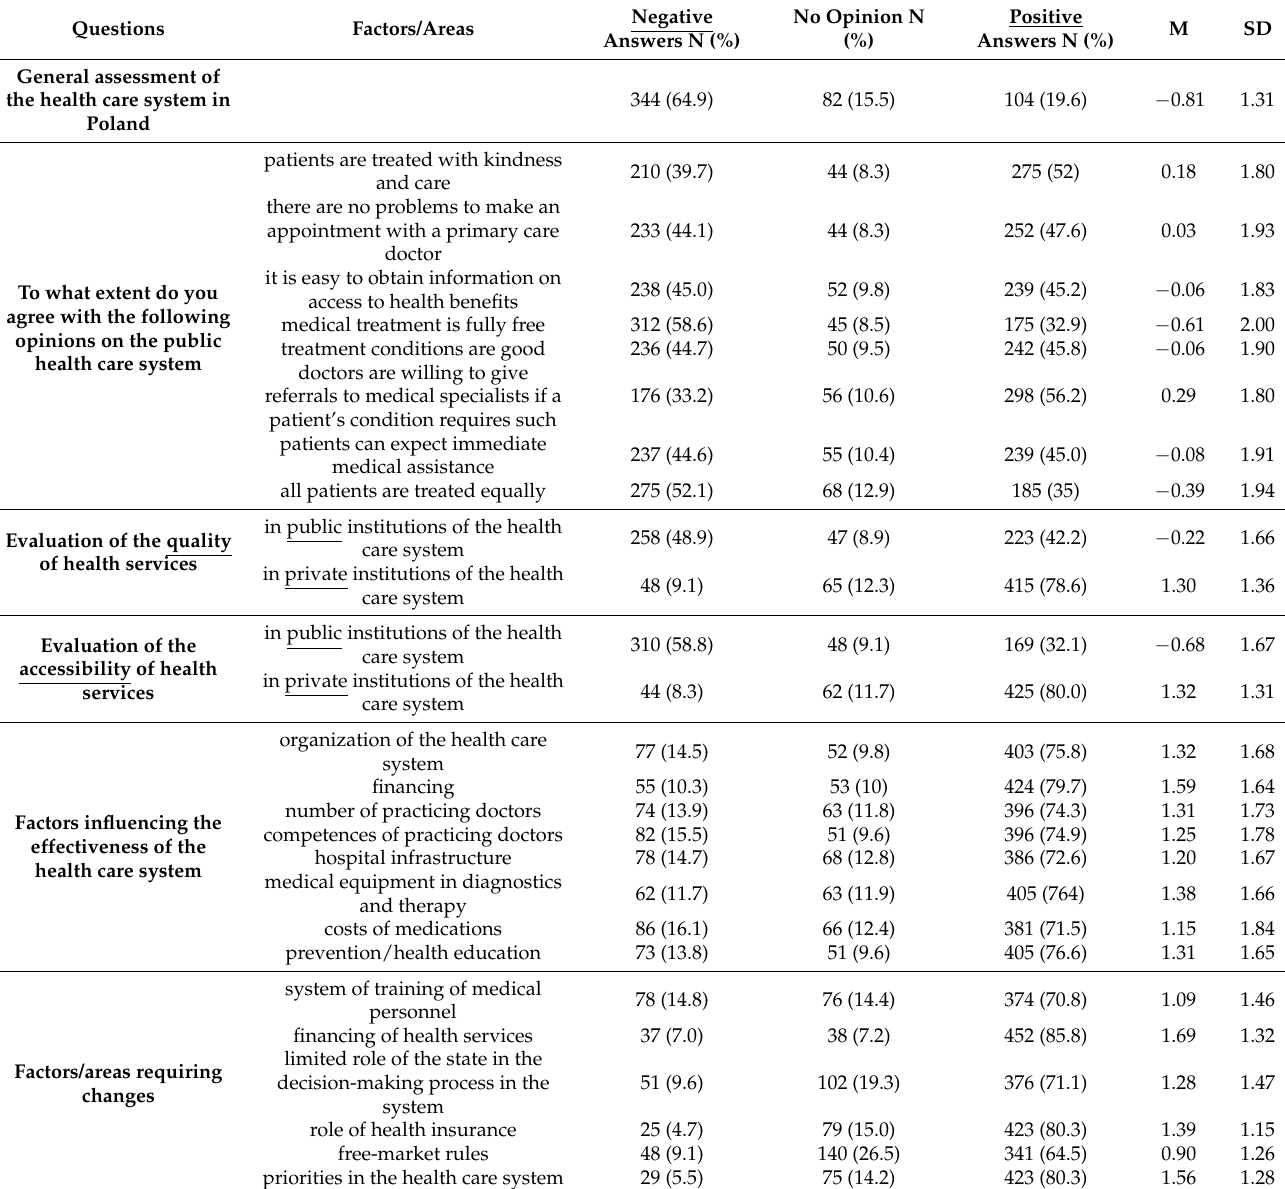
Table 2. Respondents’ opinion on the health care system in Poland, evaluation of the quality and accessibility of health services, factors influencing the effectiveness of the health care system, and factors/areas requiring changes.